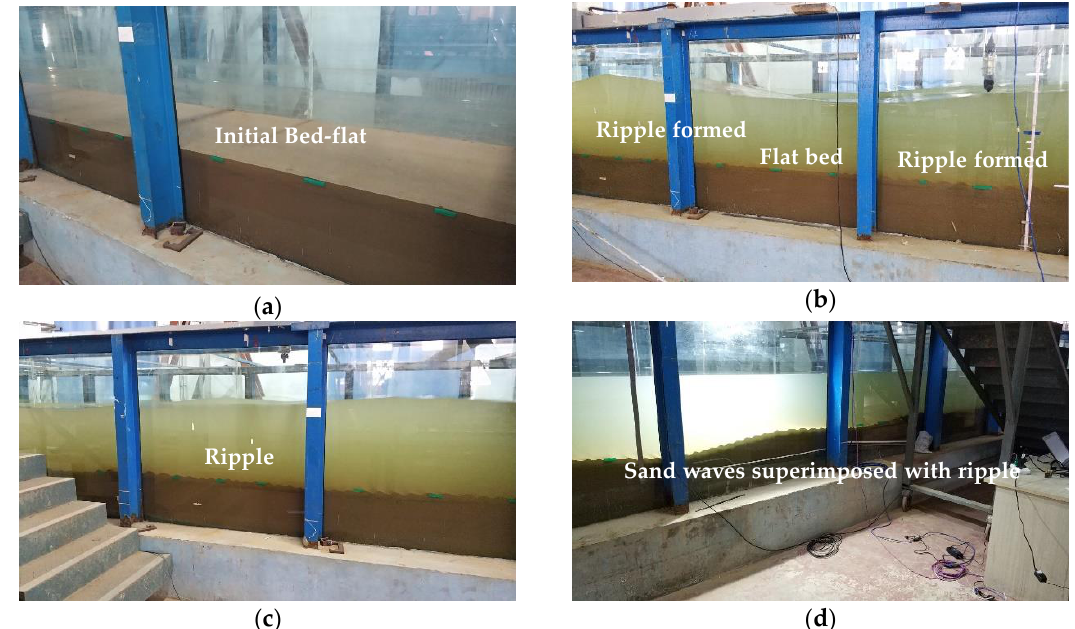
Figure 4. Bed evolution over time during the experiment. ( a ) initial time; ( b ) several minutes later; ( c ) 1 h later; ( d ) 10 h later.